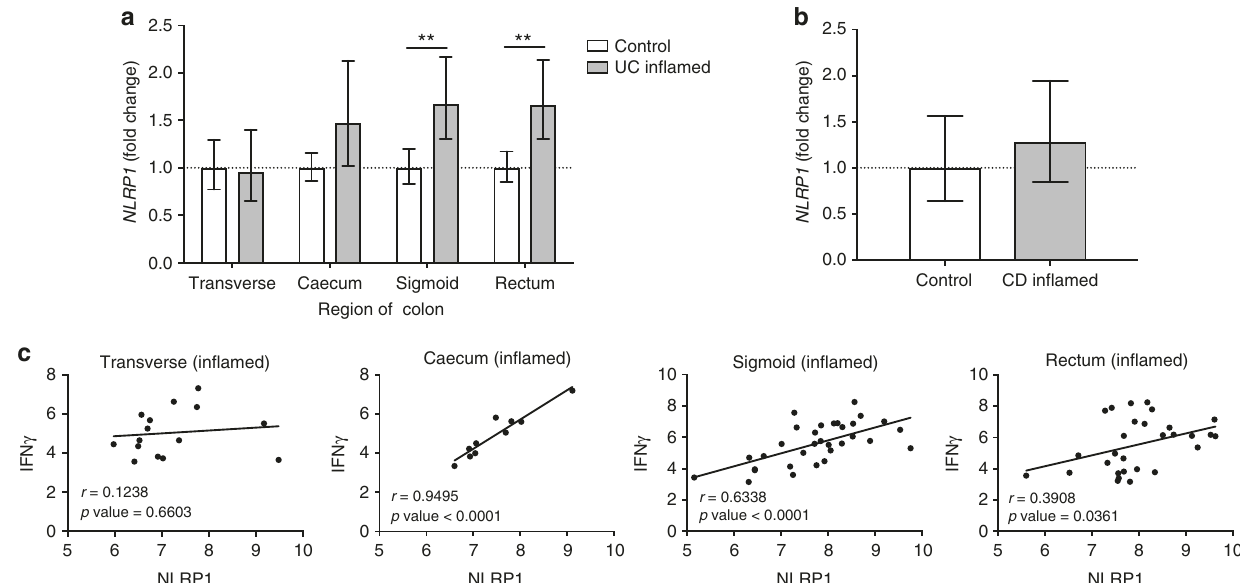
Fig. 6 NLRP1 gene expression is augmented in human ulcerative colitis which positively correlates with IFN γ gene expression in in fl amed regions of the colon. Microarray analyses were performed on colon biopsies from healthy controls ( n = 22), and patients with ulcerative colitis or Crohn ’ s disease. Gene expression data expressed as relative fold change compared to healthy controls from a transverse ( n = 15), cecum ( n = 10), sigmoid ( n = 32) and rectum ( n = 29) regions of the colon from patients with ulcerative colitis and b ileum ( n = 25) from patients with Crohn ’ s disease. Correlation between NLRP1 and IFN γ gene expression in various regions of the colon of c in fl amed regions from ulcerative colitis patients. Means ± 95% asymmetric con fi dence interval; ** p ≤ 0.01. A one-way ANOVA and Tukey ’ s post-hoc comparisons were performed on data that involved more than two comparisons, while a two-tailed, unpaired t -test was performed on data containing two comparisons. Pearson's correlation coef fi cient was used to generate the r value and the p values denoting the signi fi cance were estimated from a paired t